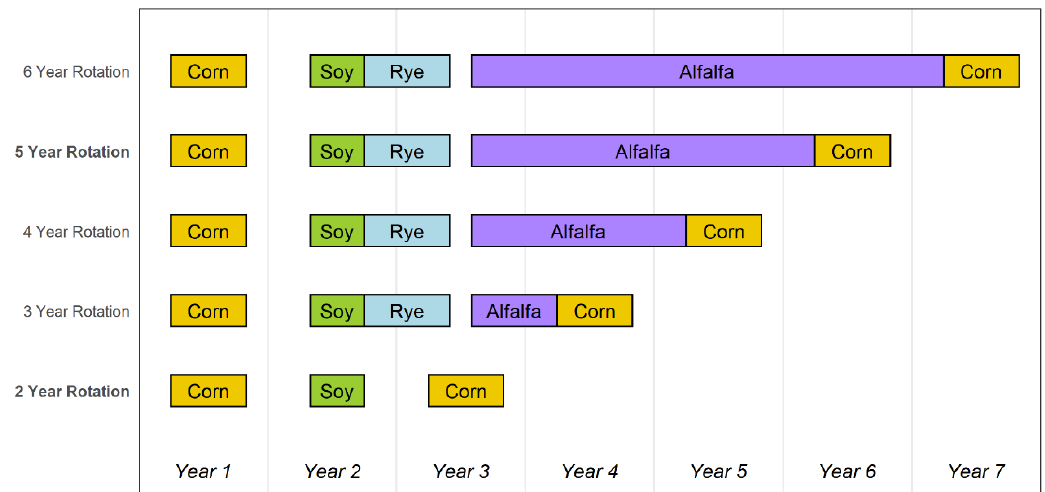
Figure 1. Crop sequences and the timing from planting to harvest or termination for 2-year and 5-year rotations (bolded) used for primary analyses, and 3-, 4-, 5-, and 6-year rotations used for secondary analyses.